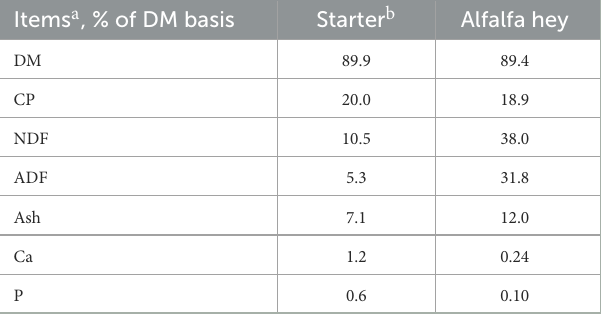
TABLE 2 The chemical composition of the